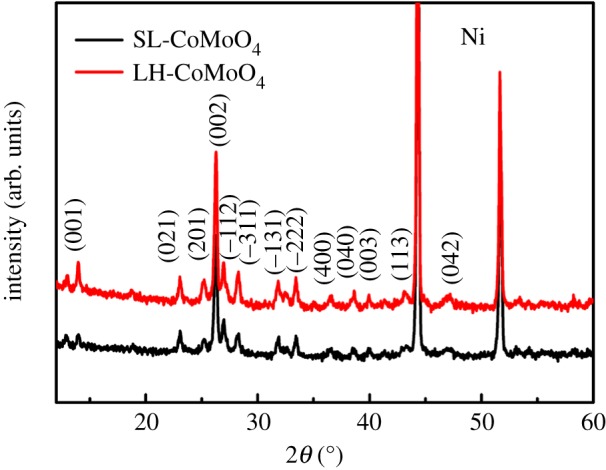
XRD patterns of the SL-CoMoO4 and LH-CoMoO4 on the nickel foam.